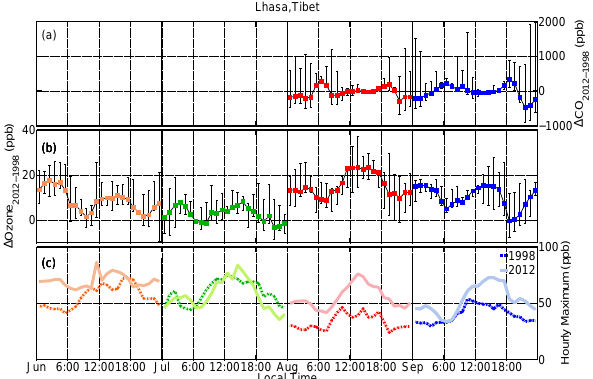
Figure 7. (a) The differences in the average diurnal variations of CO mixing ratios between 1998 and 2012 in Lhasa, the dots repre- sent monthly mean values, the black lines denote the minimum and maximum of the differences; (b) for O 3 , the markers are the same as that in (a) ; (c) the maximum O 3 mixing ratio for each hour in each month, the darker color represents the values in 1998, whereas the lighter color represents the values in